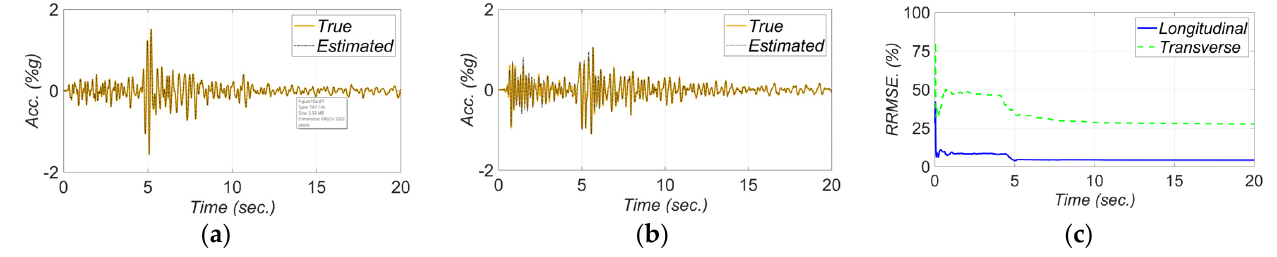
Figure 10. Comparison between true and estimated FIMs in ( a ) longitudinal and ( b ) transverse directions, and ( c ) RRMSE of the estimated FIMs.